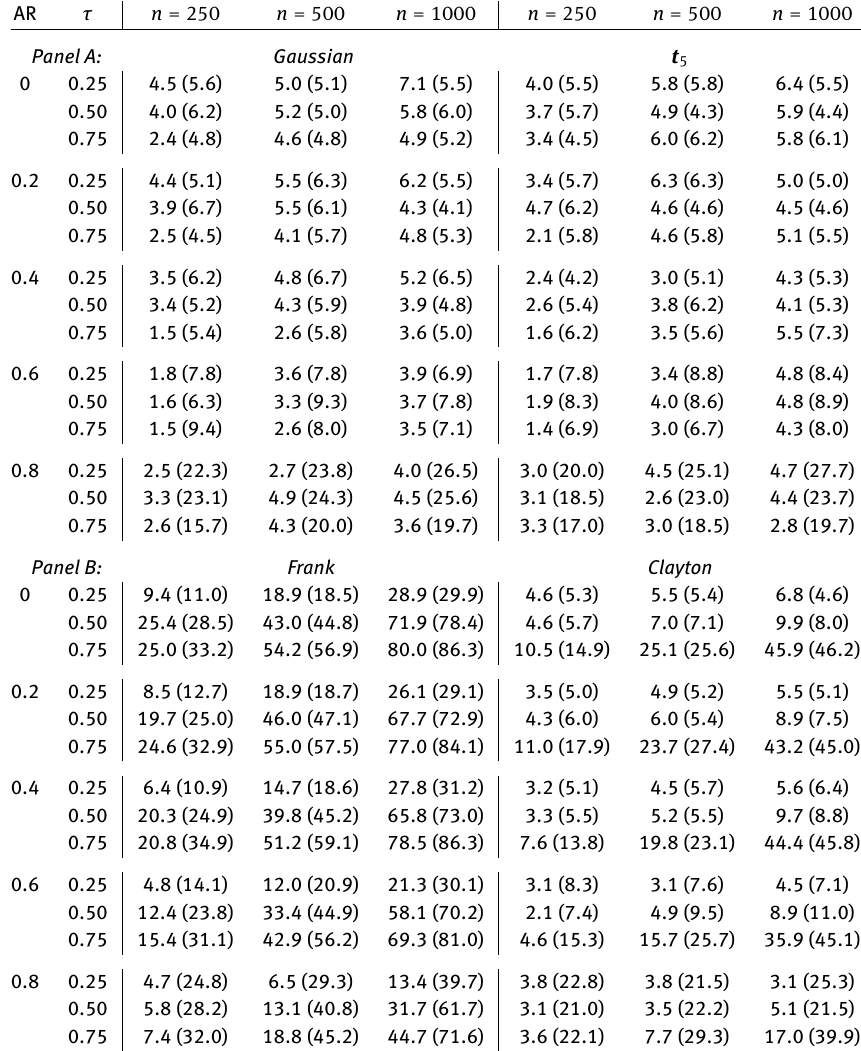
Table 1: Dimension d = 2 : Empirical level (Panel A) and empirical power (Panel B) of our test for ellipticity based on the sub- sampling procedure with block size b = (cid:98) n 0.95 /4 (cid:99) and the test from [37] based on a multiplier bootstrap (in parentheses) with significance level α = 0.05 . The model parameters are as in Figure